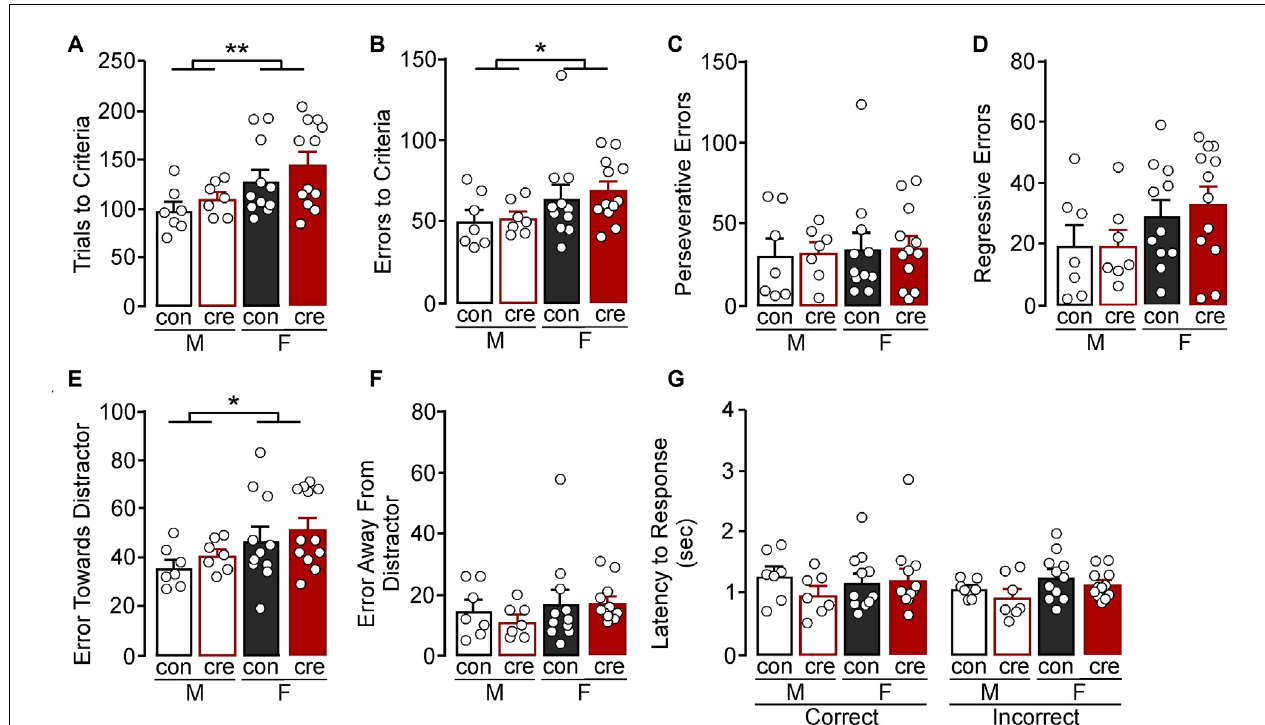
FIGURE 4 | Reversal test. (A) Females took more trials (** p < 0.01) and (B) errors to criterion (* p < 0.01) compared to males. (C) All groups had a similar number of perseverative and (D) regressive errors. (E) Females made more errors towards the cue distractor compared to males (* p < 0.05). (F) The number of errors away from the distractor was similar for all groups. (G) All groups had similar latency to respond, regardless of response type.